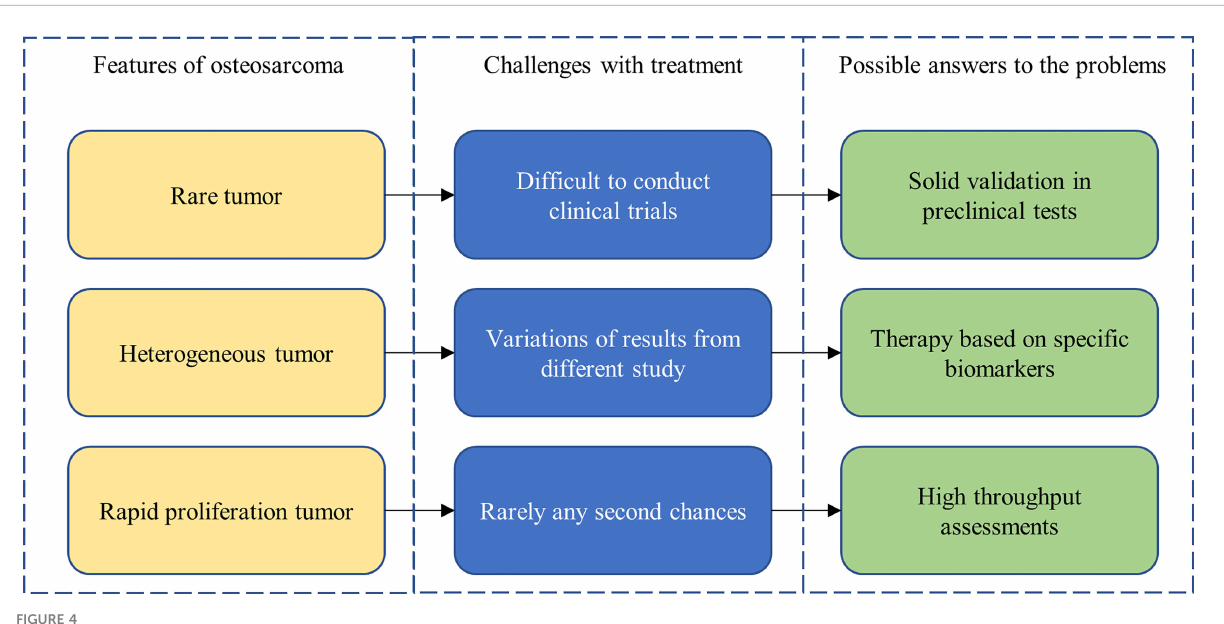
FIGURE 4 Features of, treatment challenges in, and potential solutions for